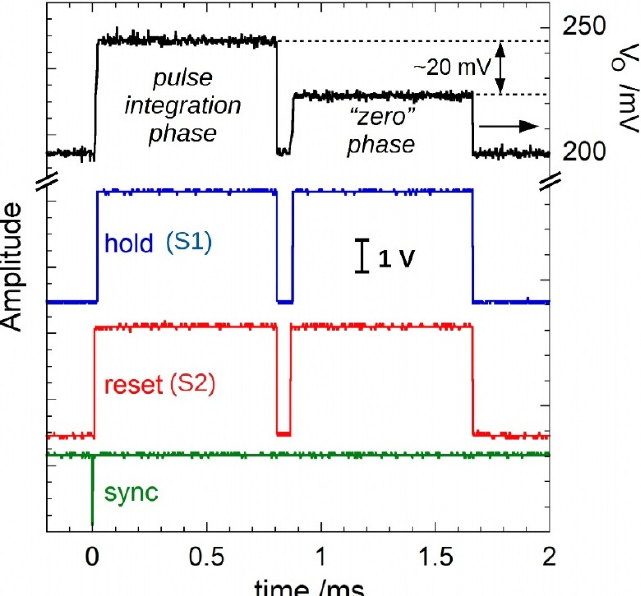
Figure 3. Example of signals generated for the two-phase method. The measurement during the “zero” phase allows for a strong reduction of the error induced by offset and leakage currents.